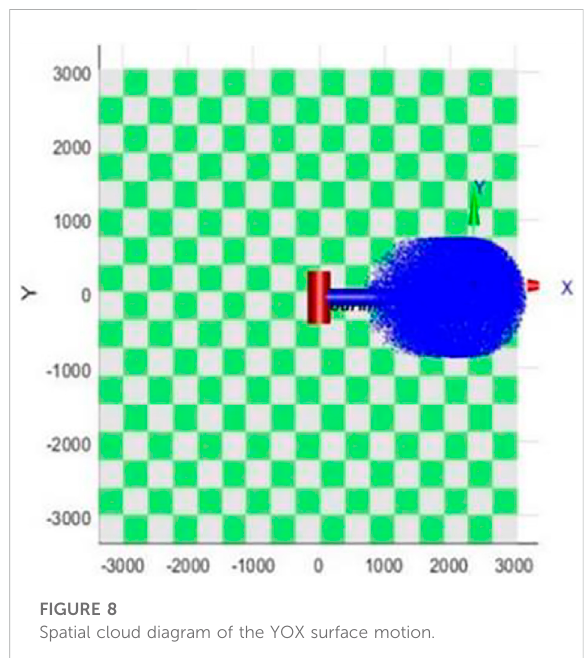
FIGURE 8 Spatial cloud diagram of the YOX surface motion.